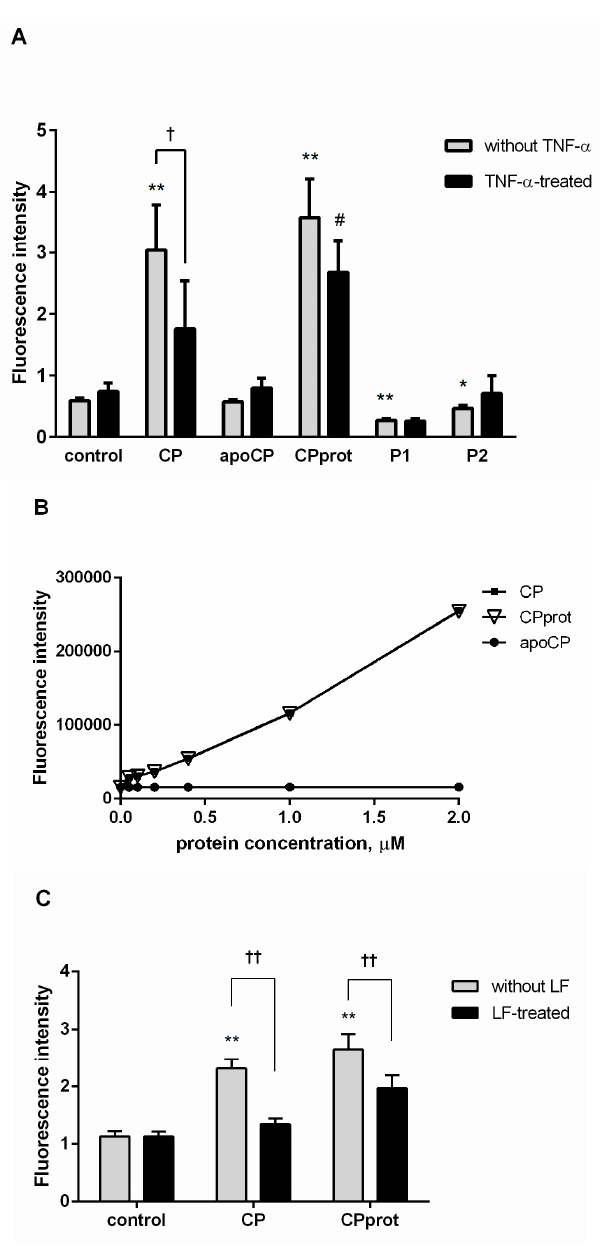
Figure 3. Effects of ceruloplasmin (CP) and its derivatives on intracellular reactive oxygen species (ROS) generation by neutrophils. H 2 DCF-DA stained polymorphonuclear leukocytes (PMNLs) were cultured with 0.5 µM CP, 0.5 µM apo-CP, 0.5 µM CPprot (proteolyzed CP), or 20 µM peptides (P1 or P2), with or without 25 ng/mL TNF- α ( A ) or 1 µM lactoferrin (LF) (C) for 60 min at 37 °C followed by fluorometric measurements of green fluorescence. ( B ) H 2 DCF-DA-oxidase activity of intact CP, CPprot (0.05–2 µM) in cell-free assay. Apo-CP was used as a control. Values represent the means ± SEM of fluorescence intensities, arbitrary units of duplicate cultures from six independent experiments; * p < 0.05, ** p < 0.01, compared to the control (medium); # p < 0.05, compared to TNF- α -treated PMNLs; † p < 0.05, †† p < 0.01 for pairs of data compared (one-way ANOVA followed by Holm–Šídák multiple comparison tests).